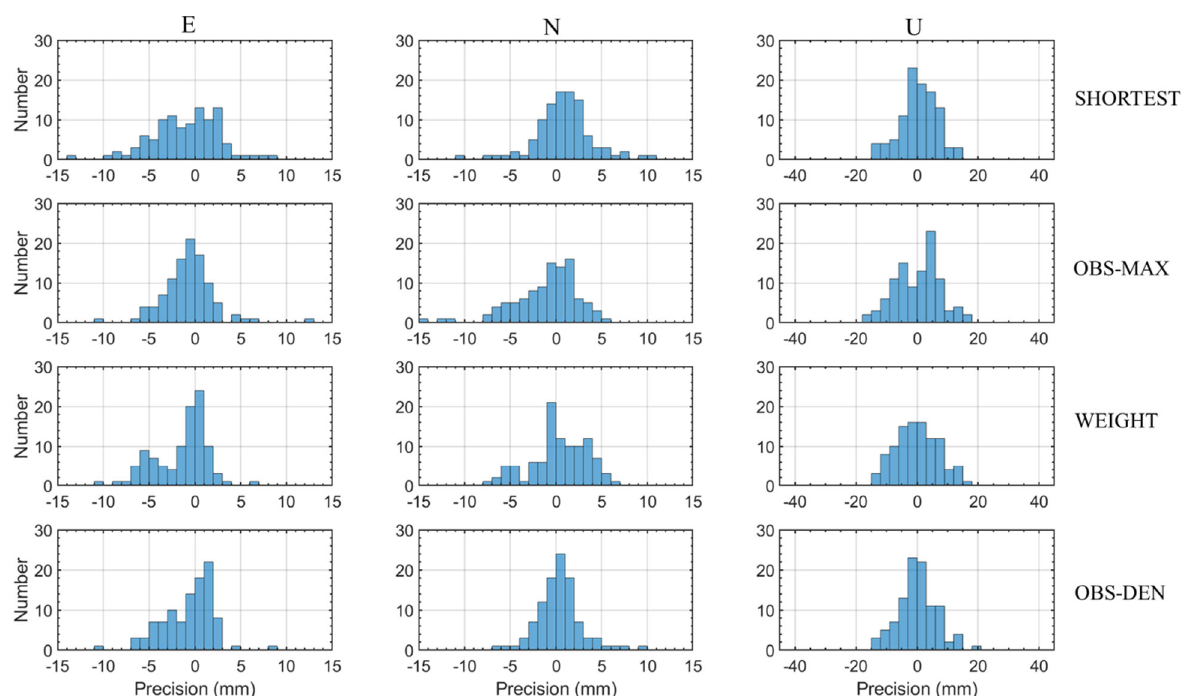
Figure 4. Histograms of single-day solutions. The x-axis of each subplot is the final station coordinate accuracy in millimeters, and the interval of each bin of North and East is 1 mm (3 mm for Up). The y-axis of each subplot represents the number of stations accommodated in each bin. The columns from left to right denote the East (E), North (N), and Up (U) component, respectively. The four methods from top to bottom are SHORTEST, OBS-MAX, WEIGHT, and OBS-DEN, respectively.